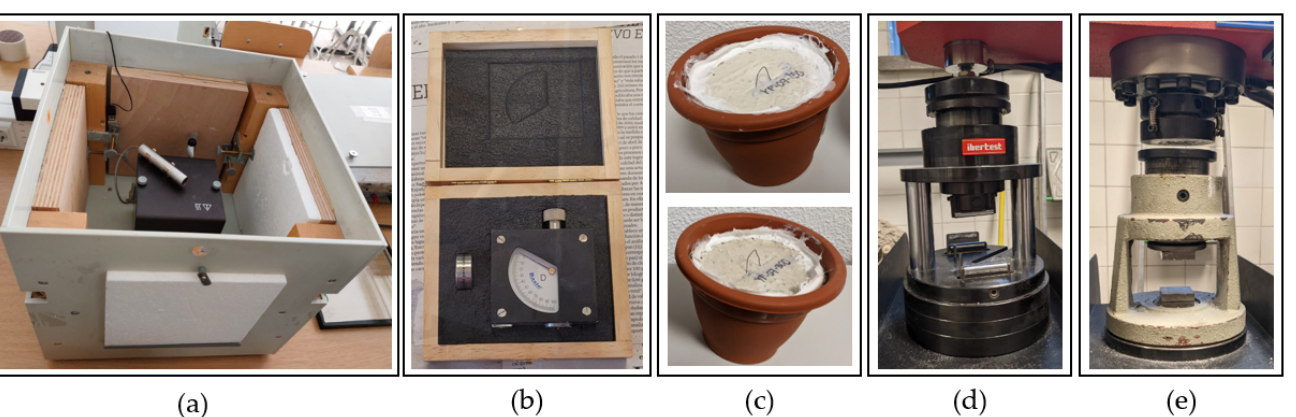
Table 5. Shore C surface hardness and bulk density.